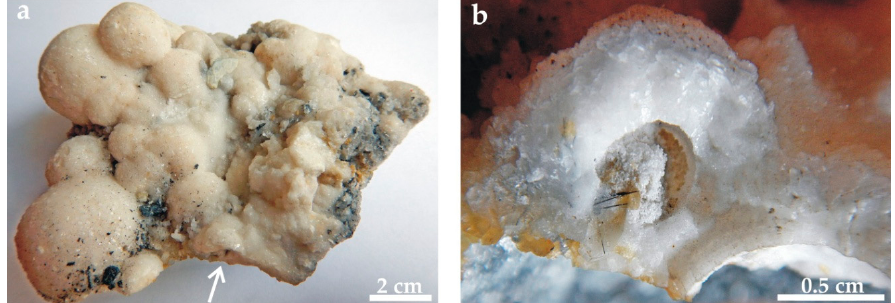
Figure 5. Attached spheres from Herja (private collection Ioan Mârza). ( a ) Group of calcite spheres that represent relatively late mineral sequence deposited on glassy microcrystalline hydrothermal quartz sequence bearing sulfides and sulfosalts; note that some late sulfosalt crystals occur on the calcite spheres; ( b ) Detail of ( a ), viewed as indicated by the arrow in ( a ), which shows the inner void of a white calcite sphere hosting several jamesonite needle-like crystals covered by sandy white calcite grains.